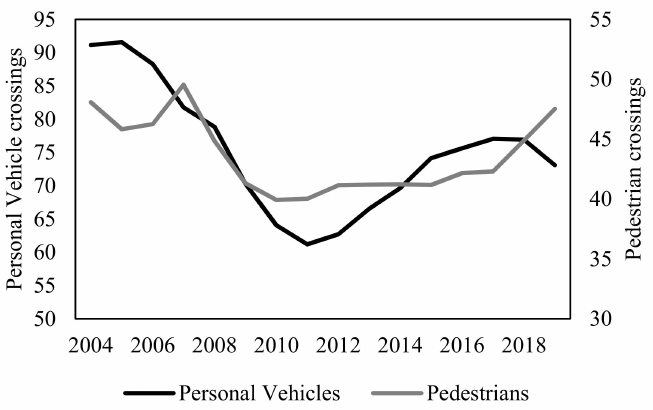
Figure 1. Annual pedestrian and personal vehicle crossings from 2004 to 2019 (millions). Note: Annual data for the 2004–2019 period. Data in millions. Pedestrian crossings are on the right vertical axis. Source: Own estimations using data from the Bureau of Transportation